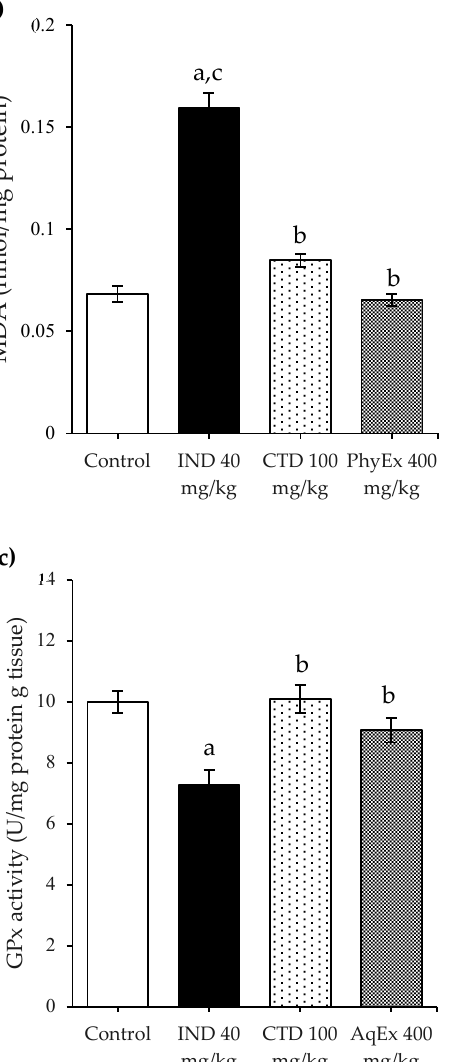
Figure 3. H and E staining of gastric mucosa of rats in the IND-induced gastric ulcer model (mag- ni fi cation at 20× and 40×). ( a , b ) Control, shows normal aspect of the lumen, mucosa, muscularis mucosa, and submucosa strata; ( c,d ) IND 40 mg/kg, shows severe hemorrhagic necrosis with leuko- cyte in fi ltrate (dark blue arrowheads) and erosion of the surface epithelial cells (orange arrow- heads); ( e,f ) CTD 100 mg/kg + IND 40 mg/kg, shows erosion of the surface epithelial cells (orange arrowheads); ( g,h ) PhyEx 400 mg/kg + IND 40 mg/kg, shows moderate hemorrhagic necrosis (dark blue arrowheads) and erosion of the surface epithelial cells (orange arrowheads). The region of the